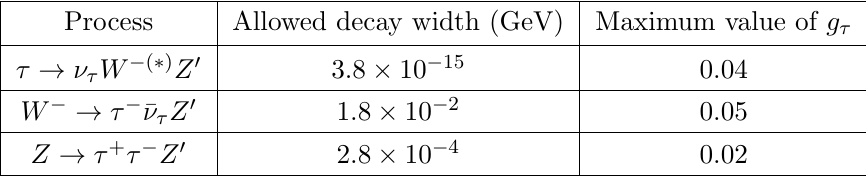
Table 3. Constraints on coupling of light vector boson Z 0 of mass 10